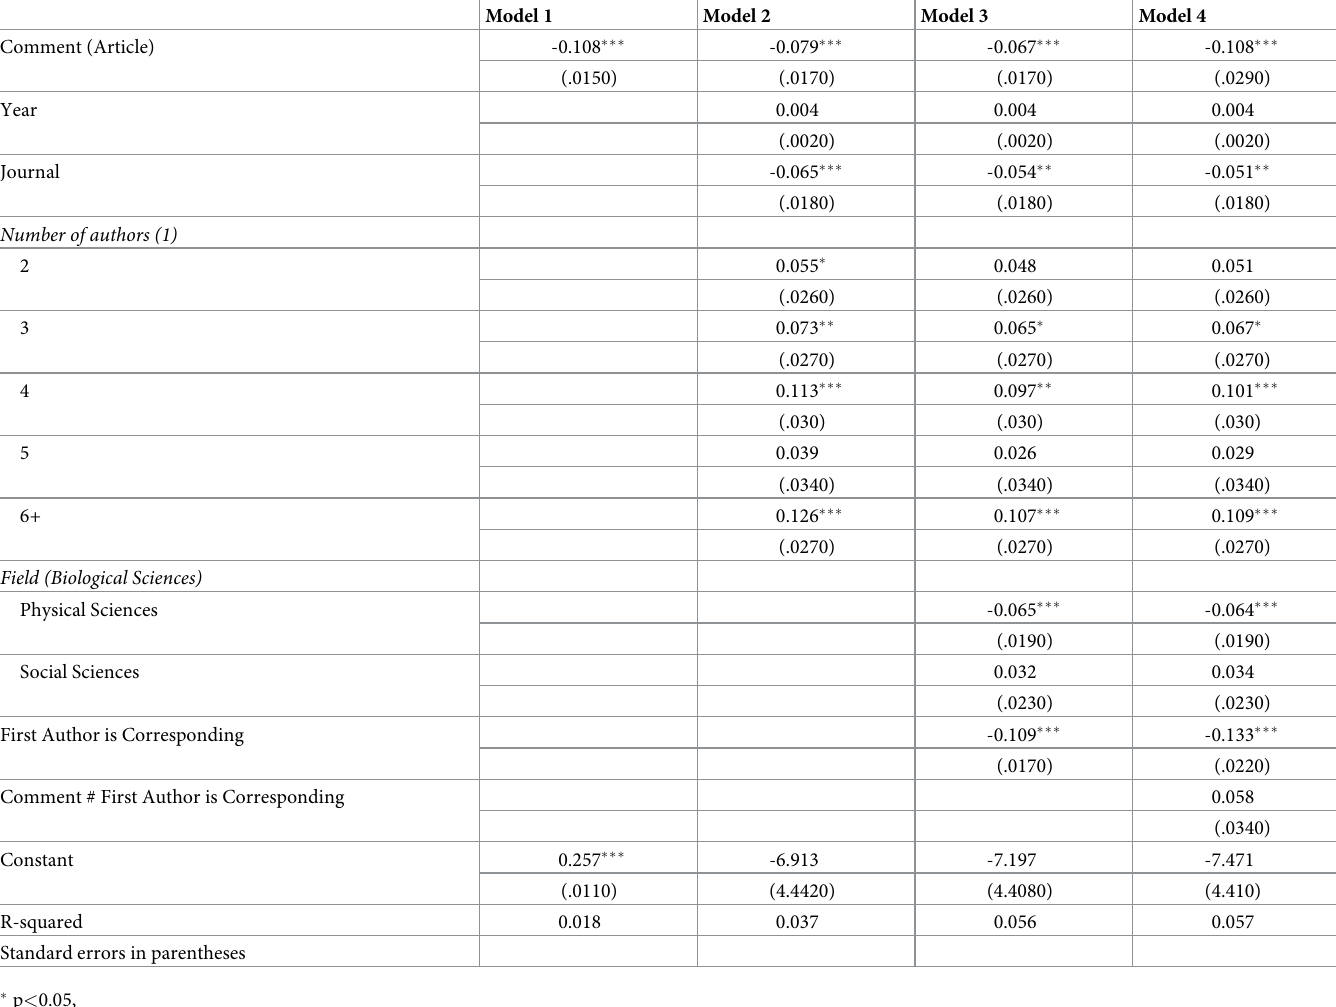
Table 1. Linear probability estimates that first author is a